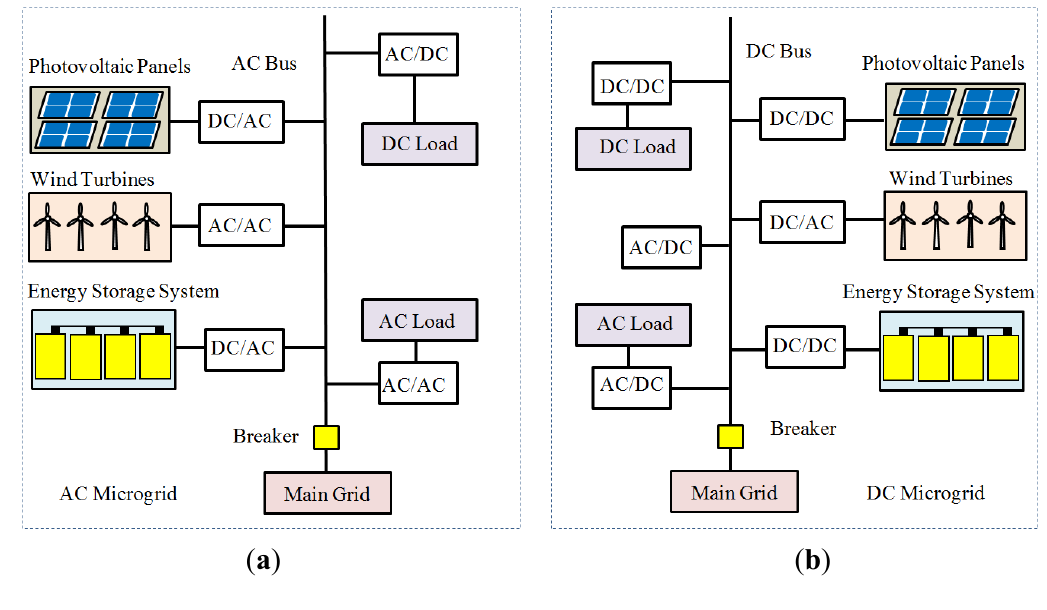
Figure 2. ( a ) AC microgrid; ( b ) DC microgrid.